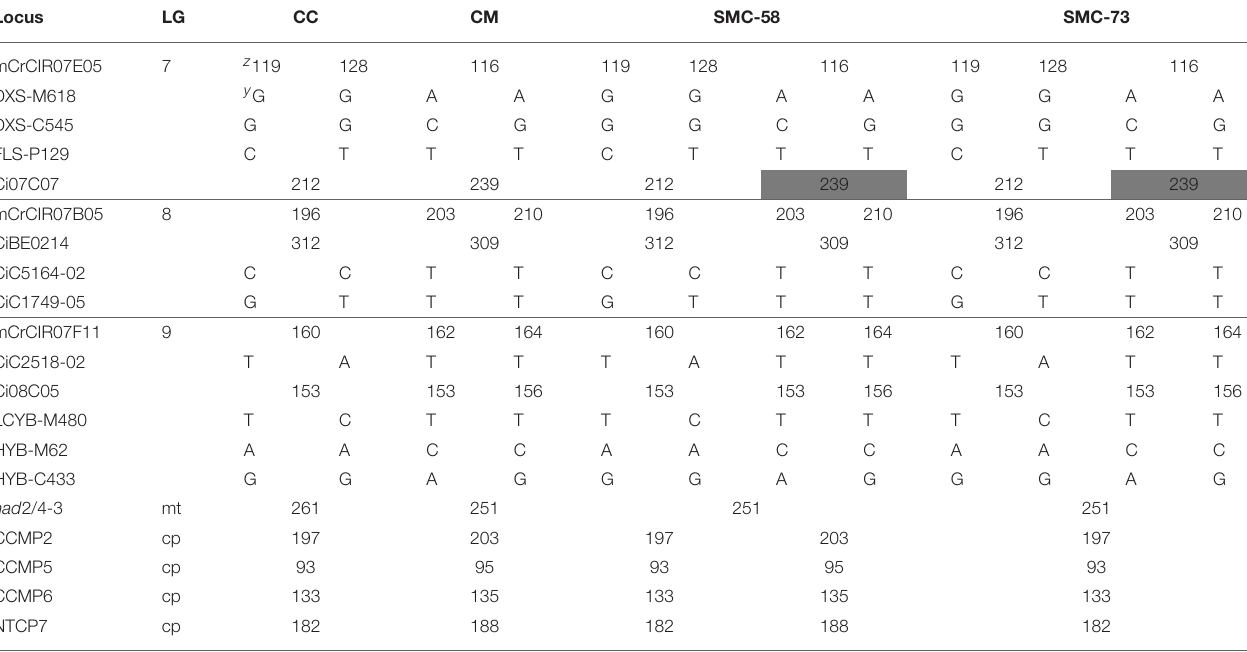
TABLE 7 | Genetic analysis using SNP and SSR nuclear markers located on LGs 7, 8, and 9 and mitochondrial (mt) and chloroplastic (cp) markers performed on SMC-58 and SMC-73 somatic hybrids that were obtained by protoplast fusion between C. macrophylla (CM) and Carrizo citrange (CC). Locus LG CC CM SMC-58